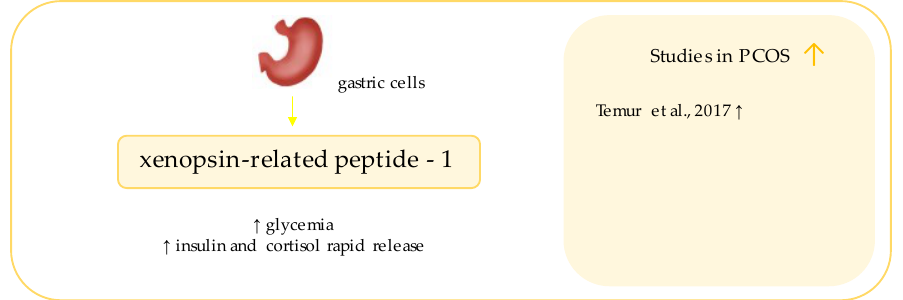
Figure 8. Role of xenopsin-related pepide in the pathogenesis of insulin resistance and PCOS. List of the studies assessing xenopsin-related peptide level in serum of the patients with PCOS. ↑ indicates that concentration level of neuregulin-4 was increased in PCOS individuals ( p < 0.05).